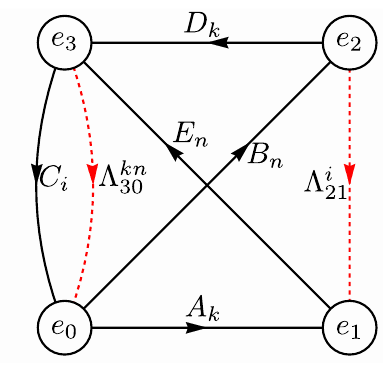
Figure 5 . The C ( Q 1 ; 1 ; 1 ) supersymmetric